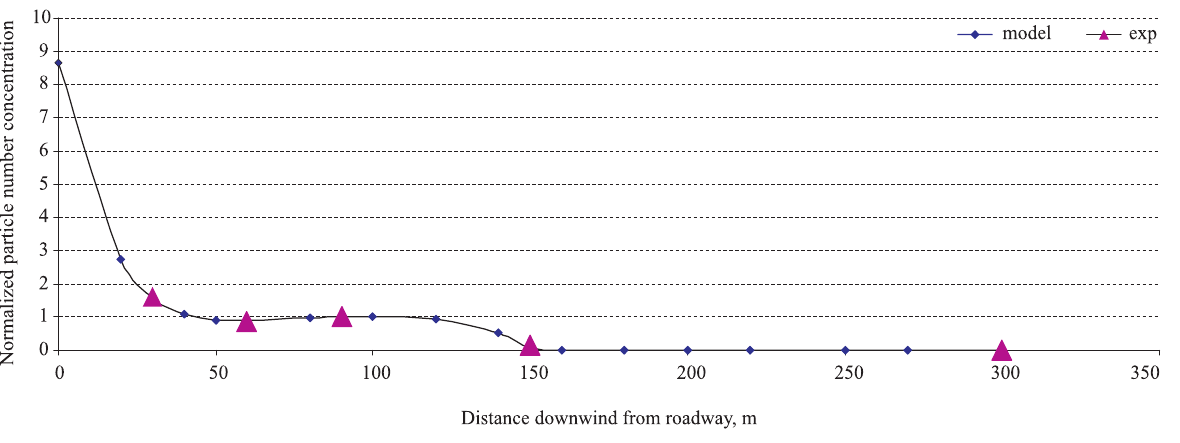
Fig. 2. Dependence of normalized experimental aerosol particle concentrations (Zhu et al. 2002) and probability density function γ (a, Δh) from the distance of the roadway when the wind speed is 1 m/s